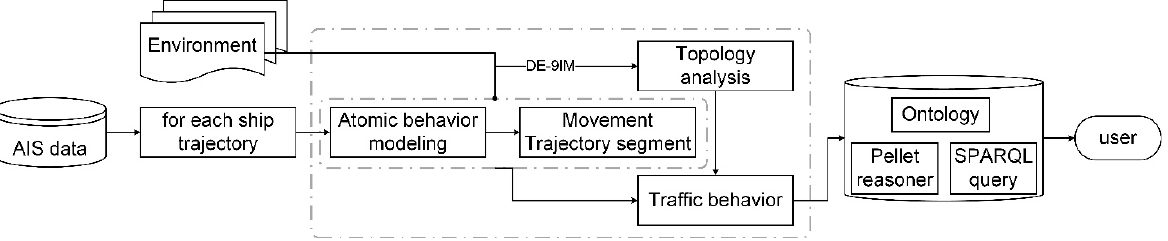
Figure 9. The process of cognitive computation, semantic reasoning, and querying of ship behavior.